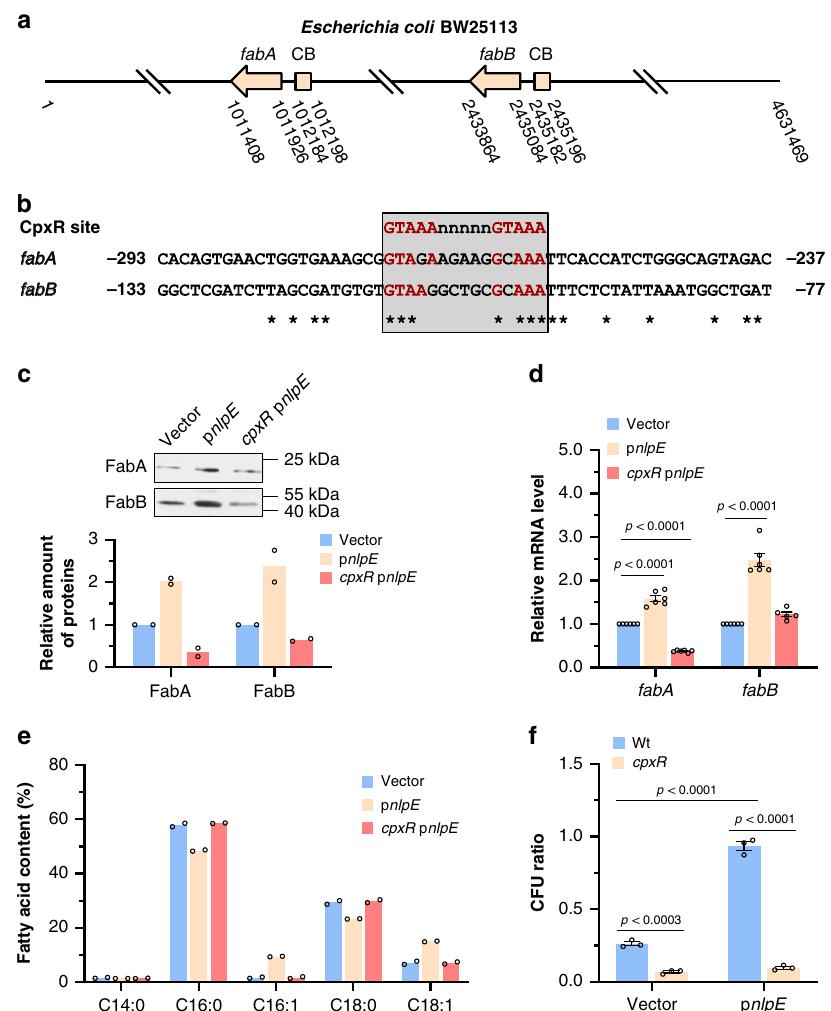
Fig. 2 Transcription of fabA and fabB is activated by two-component system CpxRA. a Schematic diagram showing the genomic locations of fabA and fabB genes and corresponding CpxR boxes. CB CpxR box. Arrows show the transcription direction of fabA and fabB genes. b Alignment of CpxR binding sequence and the promoter sequences of fabA and fabB genes. The conserved CpxR binding sequence was highlighted in red. c Western blot analysis of FabA-His 6 and FabB-His 6 protein in BW25113 strains carrying empty vector or p nlpE , and cpxR mutant carrying p nlpE grown at pH 7.0. Overexpression of outer membrane protein NlpE was reported as a speci fi c activating signal of CpxRA system. The relative amount of each protein was determined using ImageJ from two independent experiments. d Relative mRNA level of fabA and fabB in BW25113 strains carrying empty vector or p nlpE , and cpxR mutant carrying p nlpE grown at pH 7.0 determined by qRT-PCR ( n = 2 biologically independent samples with three technical repeats). e Membrane lipid composition of BW25113 strains carrying empty vector or p nlpE , and cpxR mutant carrying p nlpE grown at pH 7.0 ( n = 2 biologically independent samples). The compositions were determined by GC-MS, and fatty acid content is given as the relative peak area [(peak area of one fatty acid/total peak area) × 100%]. f Acid tolerance of BW25113 strains carrying empty vector or p nlpE , and cpxR mutant carrying vector or p nlpE after acidic challenge at pH 4.2 for 1 h ( n = 3 biologically independent samples). Error bars, mean ± SEM. Two-tailed Student ’ s t tests were performed to determine the statistical signi fi cance for two group comparisons. The source data are provided as a Source Data fi